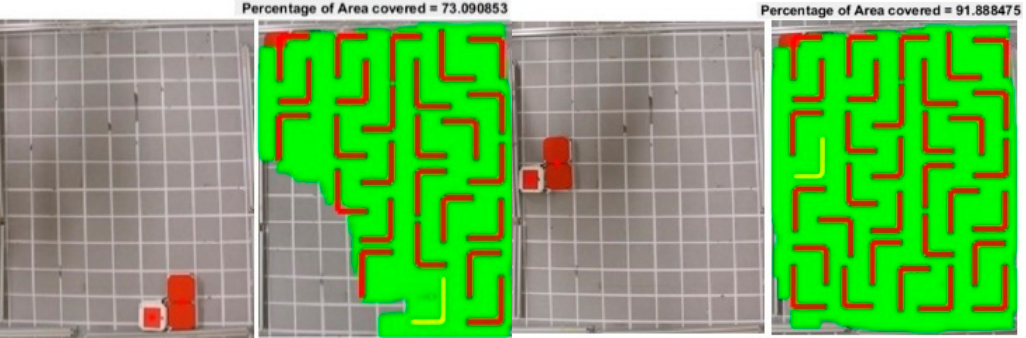
Figure 18. Experiments validating application of Theorem 2, Lemma 2.